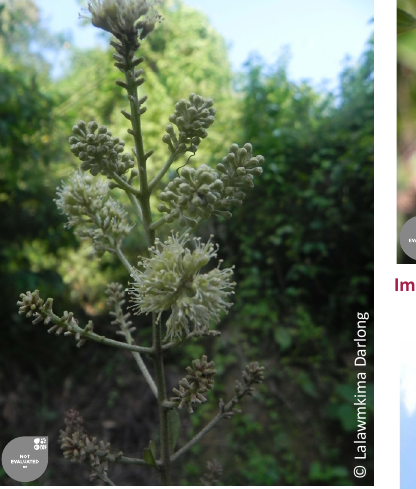
Image 2D. Byttneria pilosa